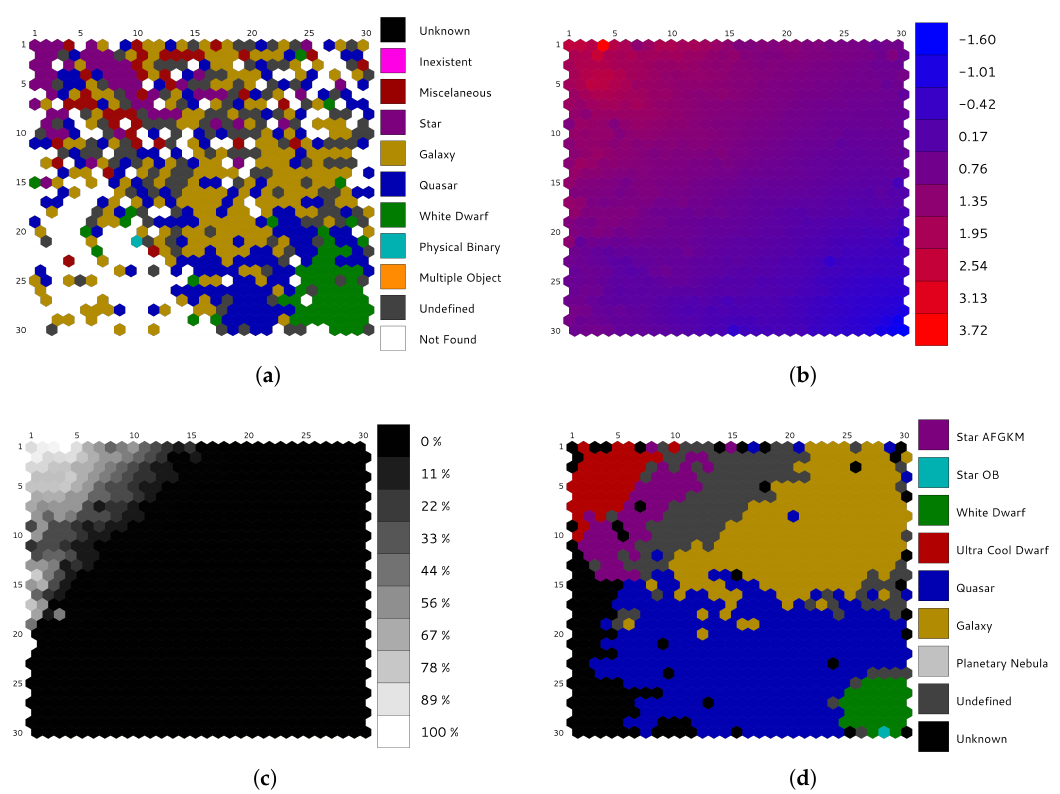
Figure 8. Specialized views for astronomical Self-Organized Maps supported by the visualization tool. ( a ) catalog labels: representative object type for each cluster using a Simbad external catalog; ( b ) color distribution: magnitude differences on blue and red wavelengths for Gaia BP/RP spectrophotometry; ( c ) category distribution: percentage of ultra-cool dwarfs populating the neurons; ( d ) template labels: labels determined using a template matching method based on Gaia